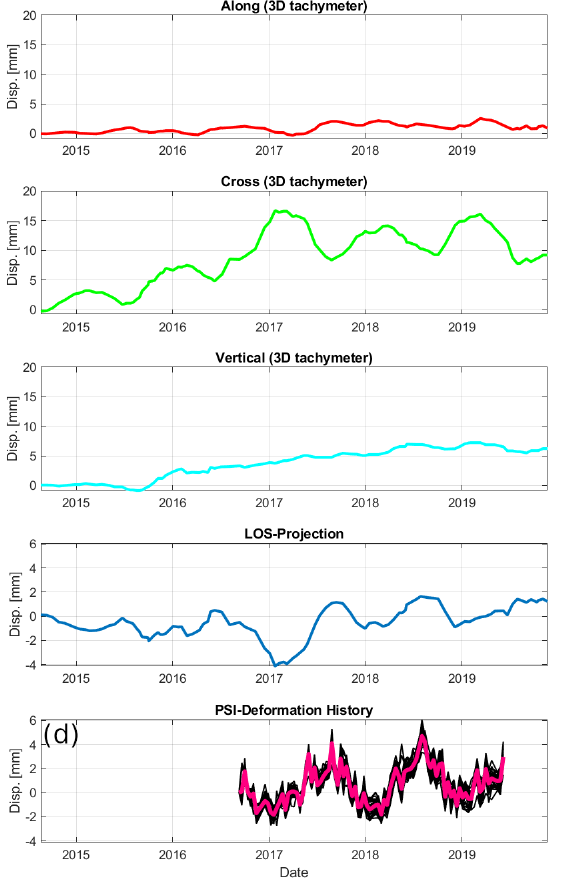
Figure 11. Deformation time series from the 3D tachymeter. The location of the prism is shown in Figure 5. The direction cross points towards the wall, along indicates horizontal movements along the wall and vertical shows the down-up movement (see Fig. 10). LOS-Projection shows the projection of this displacement onto the satellite’s line-of-sight direction, it matches the displacement history of the closest cluster